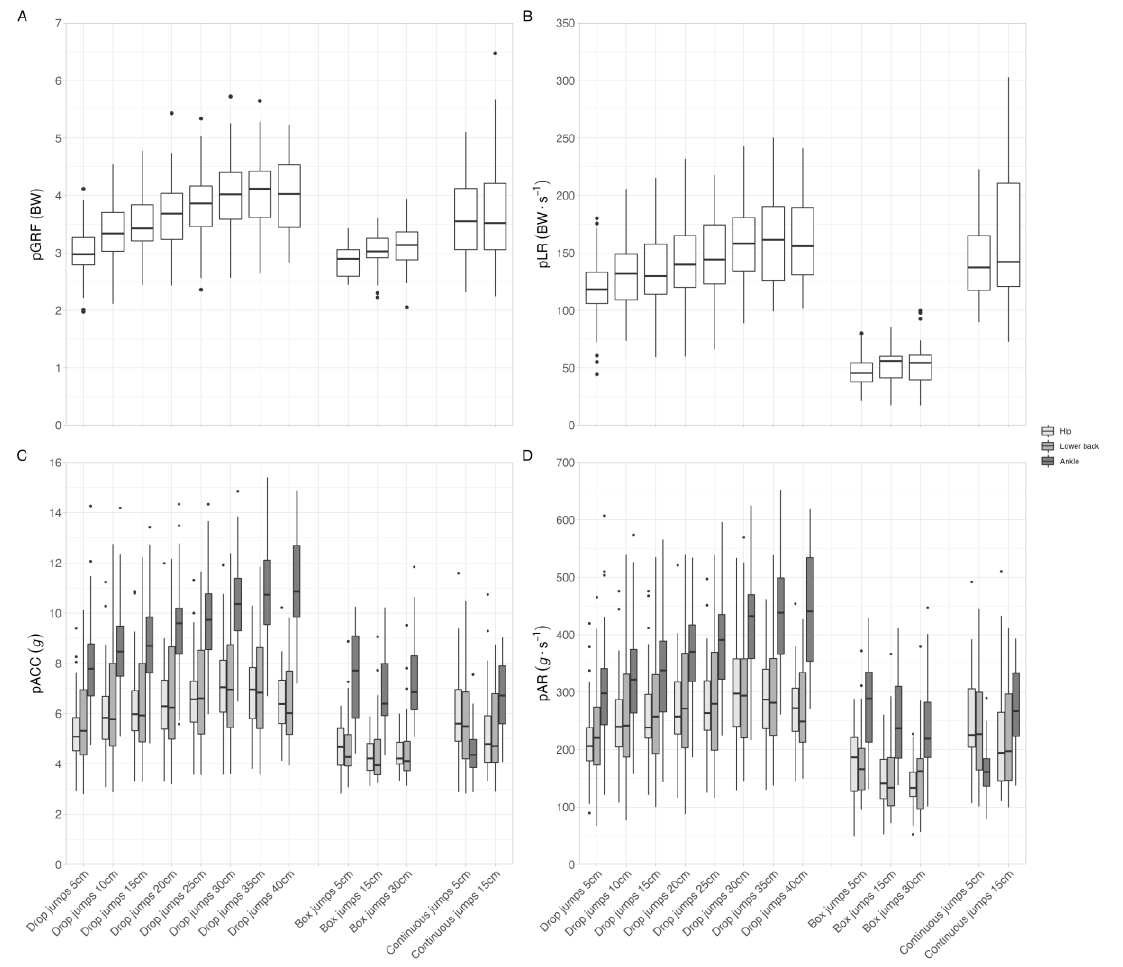
Figure 6. Distribution of the resultant vectors of mechanical loading (peak ground reaction force on Panel ( A ) and peak loading rate on Panel ( B )) and acceleration (peak acceleration on Panel ( C ) and peak acceleration rate on Panel ( D )) variables per jump type and height combination. Abbreviations: BW, body weight; pACC, peak acceleration; pAR, peak acceleration rate; pGRF, peak ground reaction force; pLR, peak loading